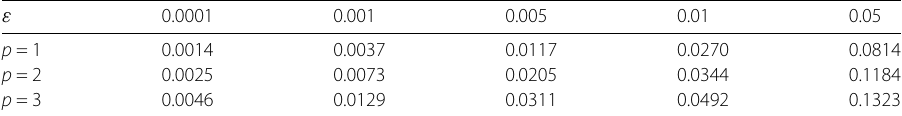
Table 1 k = 0.5, the relative root mean square errors (cid:10) ( u ) for various noise levels ε 0.0001 0.001 0.005 0.01 0.05 p = 1 0.0014 0.0037 0.0117 0.0270 0.0814 p = 2